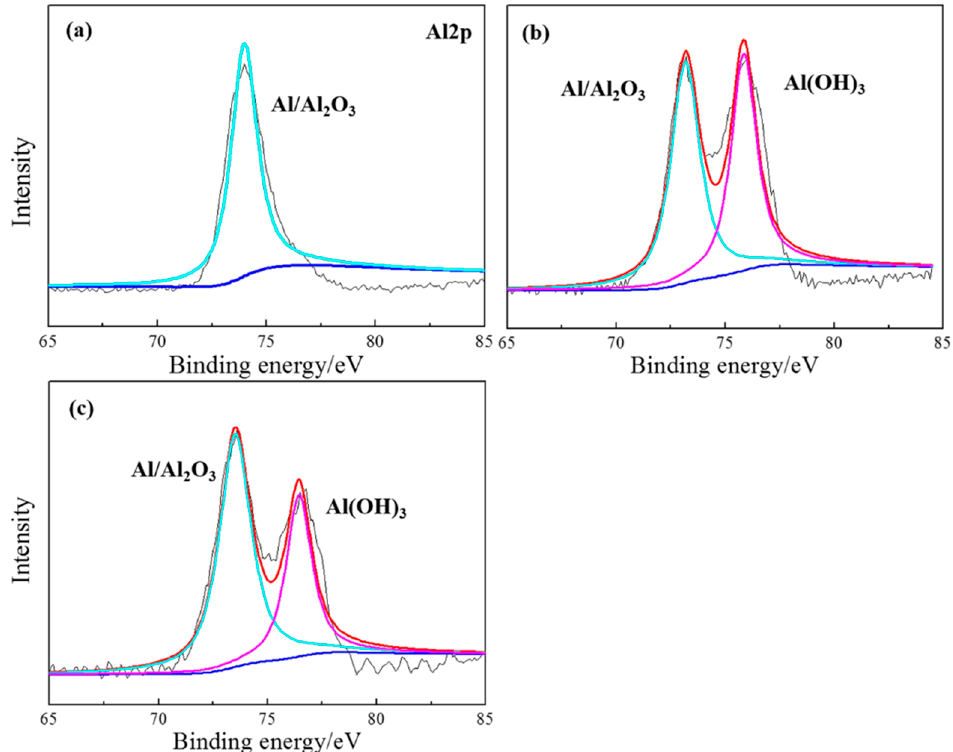
Figure 12. XPS results of the aluminum base beneath coatings with different content of PANI-SSA ( a ) 1 wt. %; ( b ) 2 wt. %; ( c ) 4 wt. % after electrochemical impedance measurement.